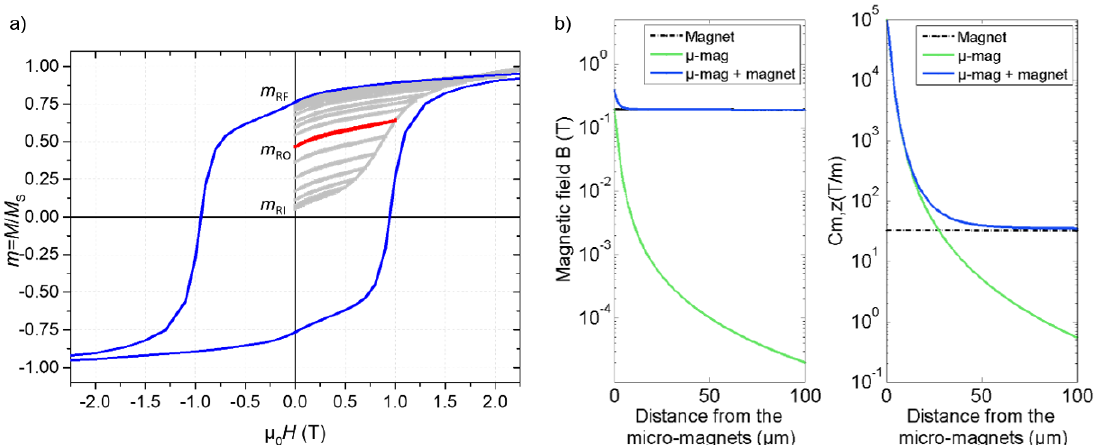
Figure 3. ( a ) Magnetization of the NdFeB@PDMS membrane, measured out-of-plane. The light grey curve is the first magnetization curve with successive measurements of remanent magnetization. The thick red curve highlights the remanent magnetization at 1 T. The blue curve is the full magnetization loop. ( b ) COMSOL simulations of the magnetic field and magnetic field gradient (defined by Cm,z) generated by the micro-magnets (µ-mag) as a function of the distance from the composite surface, with or without an external magnet below the composite surface.